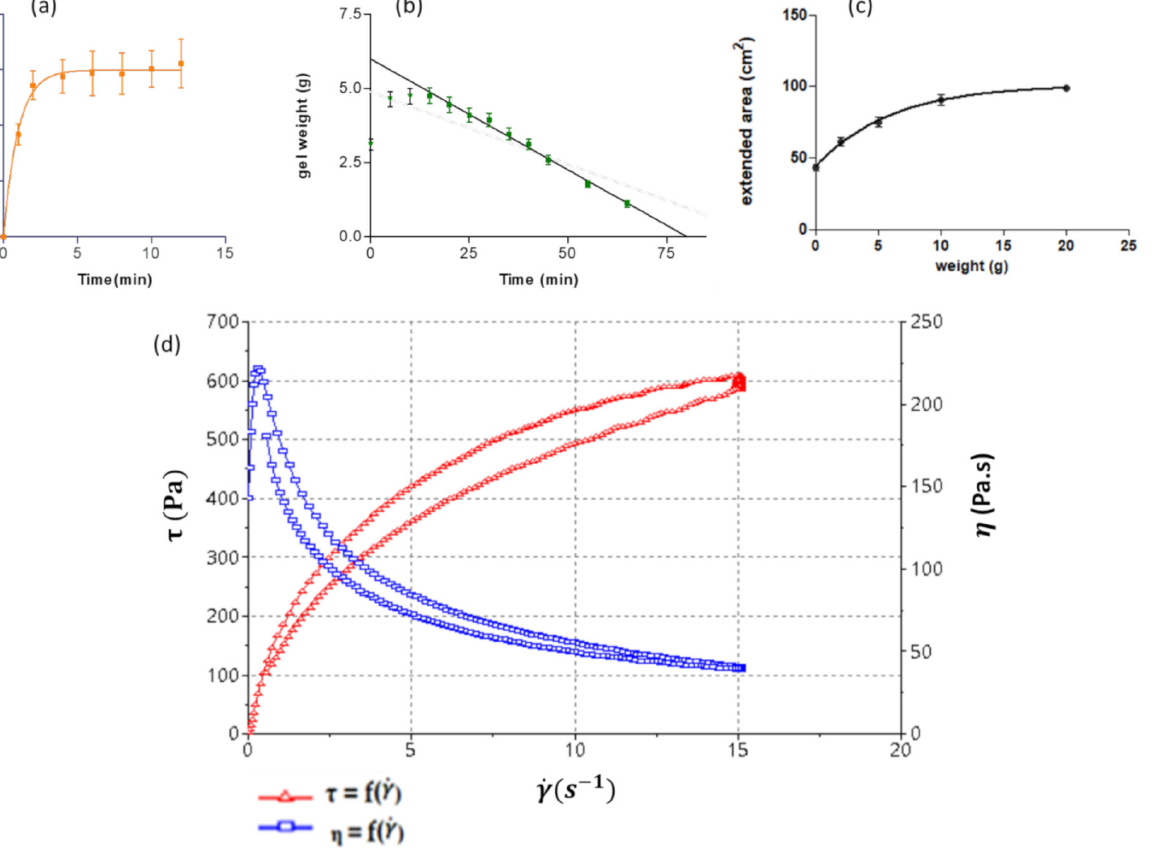
Figure 1. Characterization of the alginate-HA-gel KT 2%: ( a , b ) Modelling plots represented as variations in the hydrogel’s weight over time: Swelling Ratio (SR) and degradation assay, respectively. ( c ) Extended area in cm 2 after applying 2, 5, 10, and 20 g of weight. Expressed as means ± standard deviation (n = 3). ( d ) Flow Curve of alginate-HA hydrogel KT 2%. The blue curve represents the formulation viscosity. The red curve represents the shear stress of the